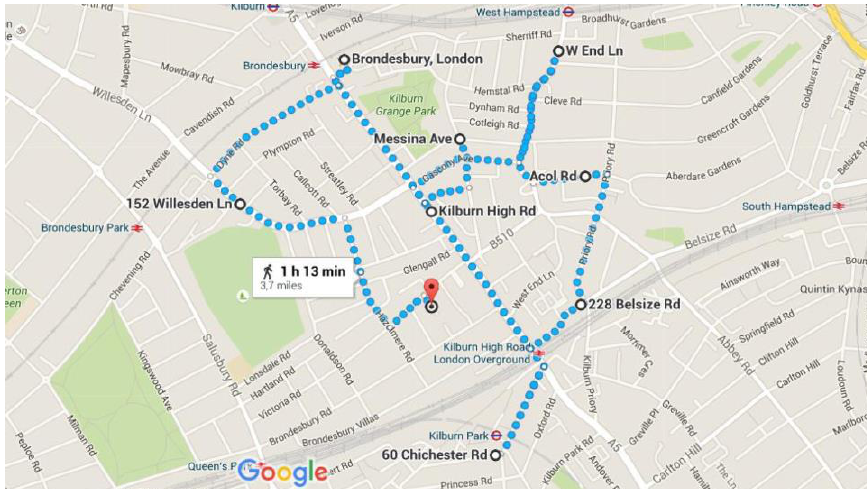
Figure 3. Emerging paths around KHR from VGI